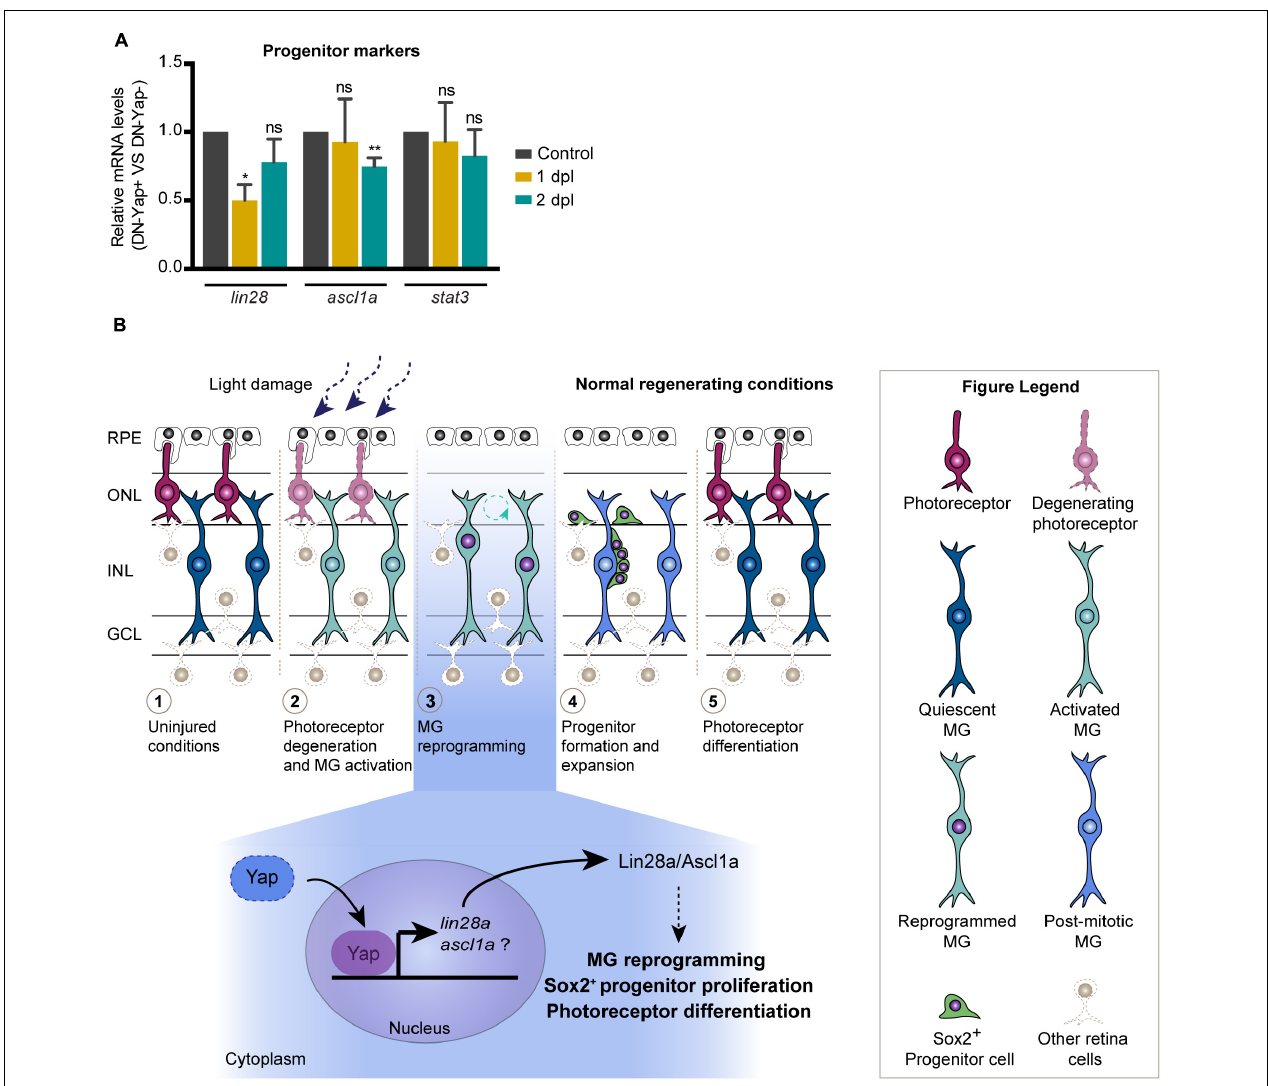
FIGURE 4 | Model for the role of Yap during zebrafish retina regeneration. (A) Relative gene expression of progenitor markers at 1 and 2 dpl ( n = 4 biological replicates for 1 dpl; n = 7 biological replicates for 2 dpl) in DN-Yap+ versus DN-Yap − controls. ns, non-significant; * p < 0.05, ** p < 0.01. Paired t -test for the relative gene expression of progenitor markers. (B) In the zebrafish model system, in response to a light-induced lesion, photoreceptors start to degenerate, and quiescent Müller glial cells (MGs) become activated in response to the insult. Activated MGs then undergo a reprogramming event, reentering the cell cycle, and dividing and producing a pool of progenitor cells that migrate to the lesion site and differentiate into new photoreceptors. Based on our findings, we propose a model for the role of Yap during MG reprogramming after photoreceptor damage. Our data suggest that Yap is required to regulate MG reprogramming possibly via a lin28a – ascl1a -dependent mechanism, being necessary for correct Sox2 + progenitor proliferation and photoreceptor differentiation. We suggest that Yap regulates lin28a expression; however, if ascl1a is also regulated by Yap or Lin28a, it still needs further